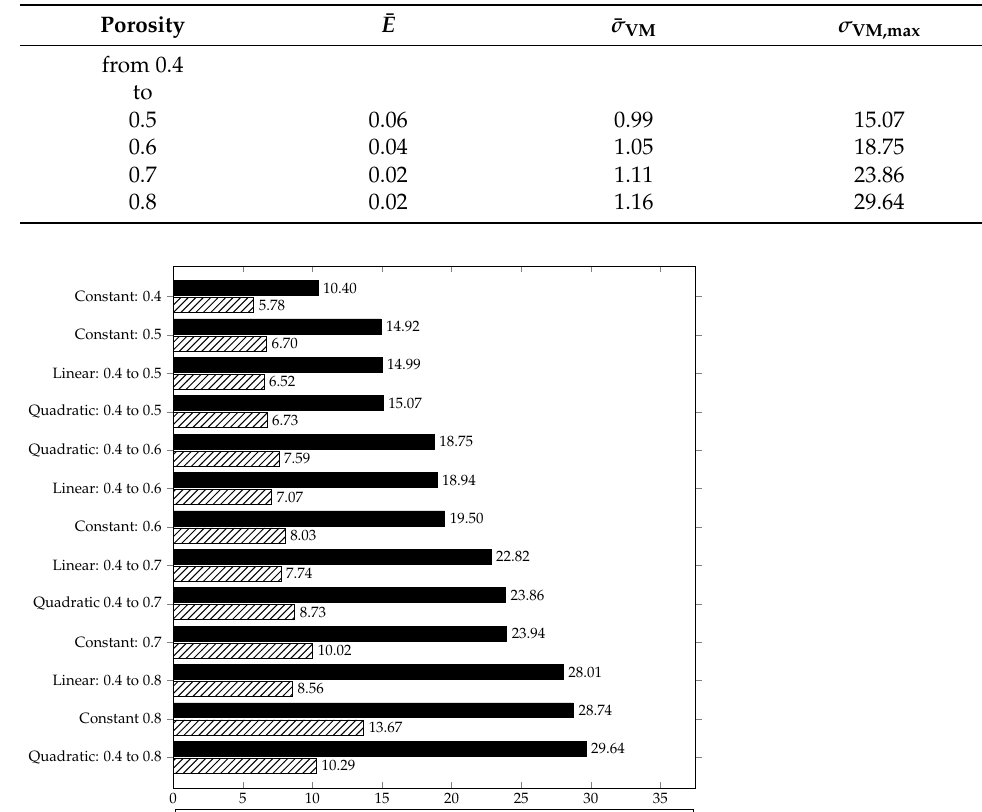
Table 6. Scaled results of the gyroid structure with a quadratic gradient [dimensionless] of the normalised effective Young modules ¯ E , a mean von Mises stress ¯ σ VM , and a maximum von Mises stress σ VM,max , which is given for different porosities.